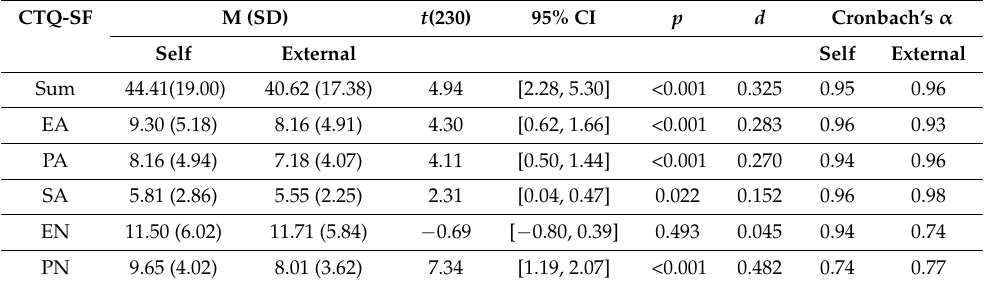
Table 1. Descriptive Statistics and Mean Differences between CTQ-SF Self- and External